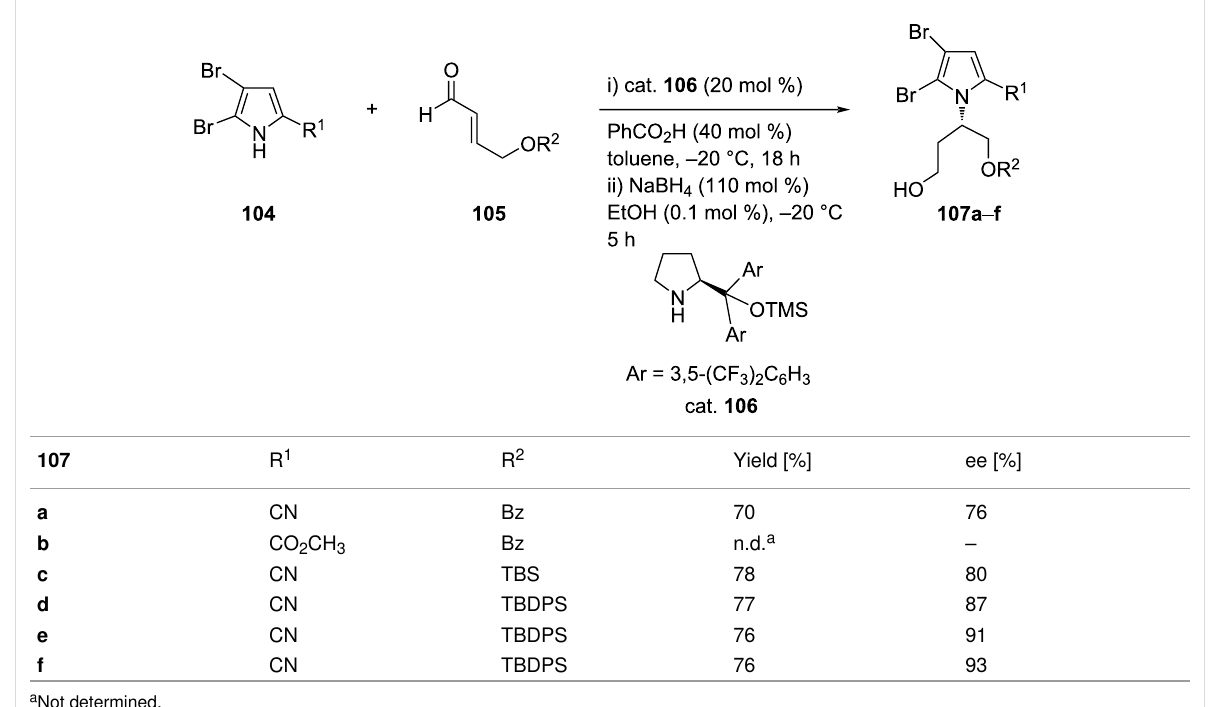
Table 24: Asymmetric aza-Michael additions of pyrroles to protected ( E